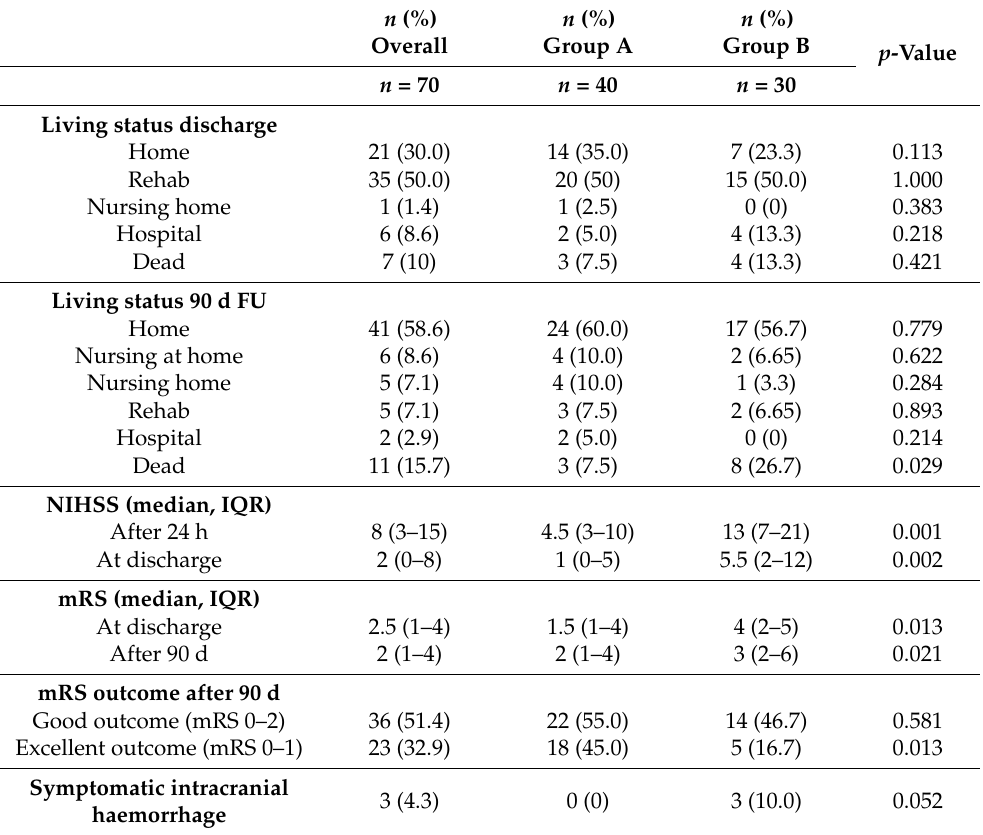
Table 2. Data are presented as numbers (%) or if marked as medians (IQR). NIHSS, National Institute of Health Stroke Scale; mRS, modified Rankin